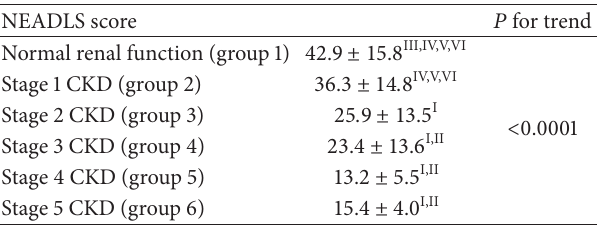
Table 3: Comparison of NEADLS scores among patients with normal renal function and CKD. NEADLS score